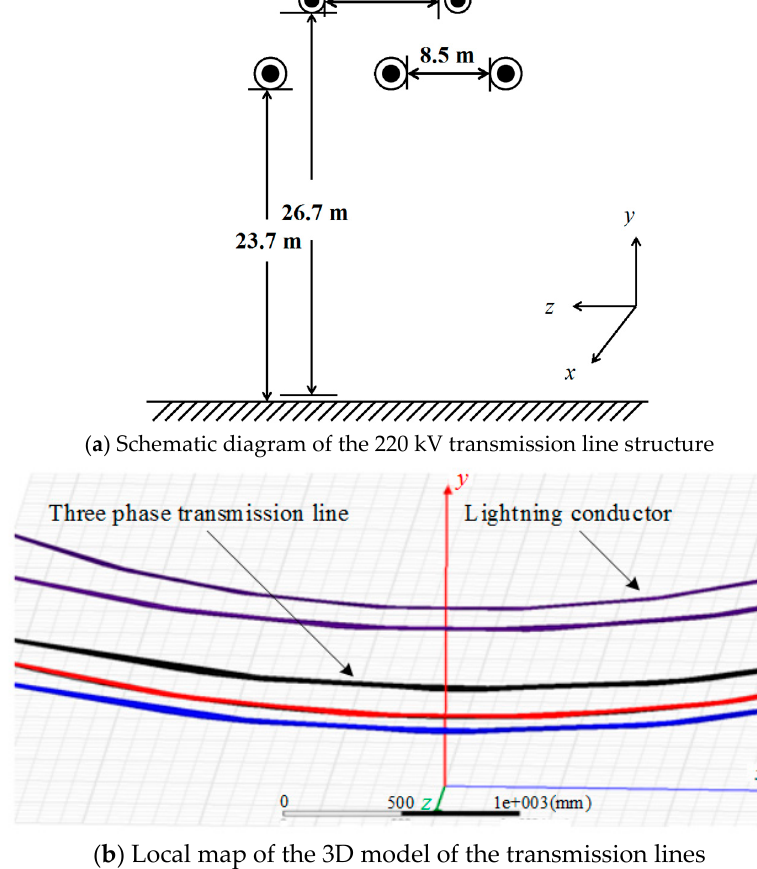
Figure 5. The 220 kV three-phase transmission line simulation model.